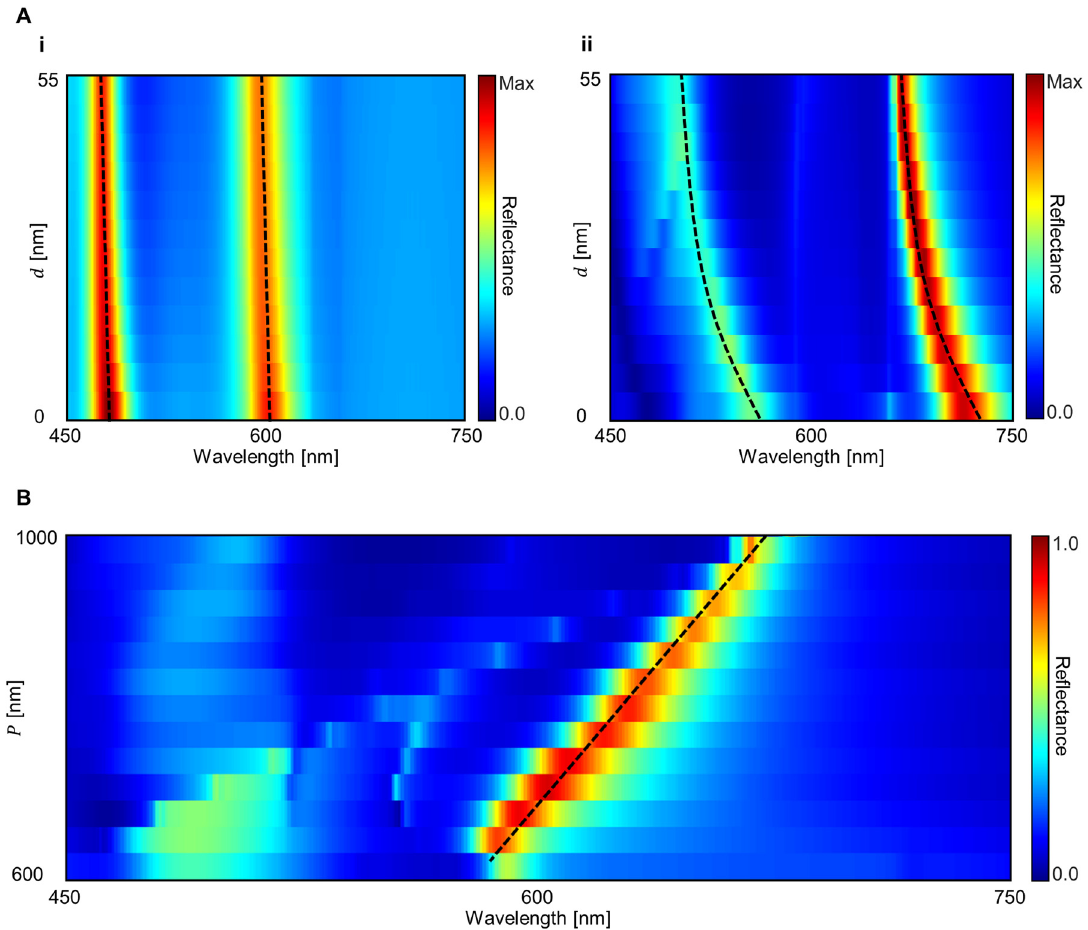
Figure 4: Effect of geometrical parameters on the resonance peaks. (A) The reflectance spectraof TNMswith(i) l 1 = 30nm, l 2 =270nm, and l 3 = 30nm and(ii) l 1 = l 2 = l 3 = 270nmwhen d is variedfrom 0 to 55 nm. The re fl ectance intensities are normalized to themselves for clarity. (B) The re fl ectance spectra of TNMs ( l 1 = l 2 = l 3 = 270 nm) when the periodicity of the superpixel is varied from 600 to 1000